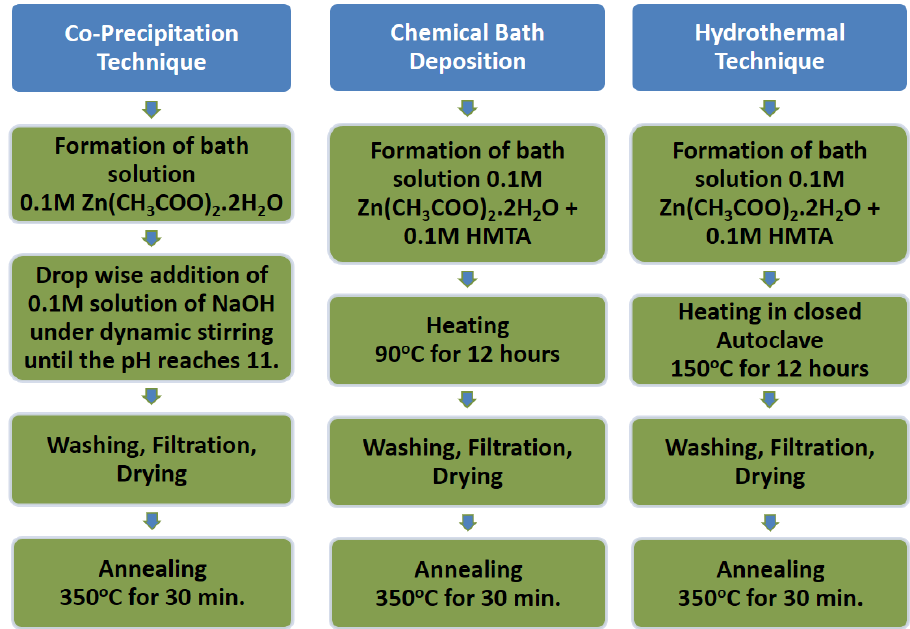
Scheme 1. Schematic representation for the synthesis of ZnO via various